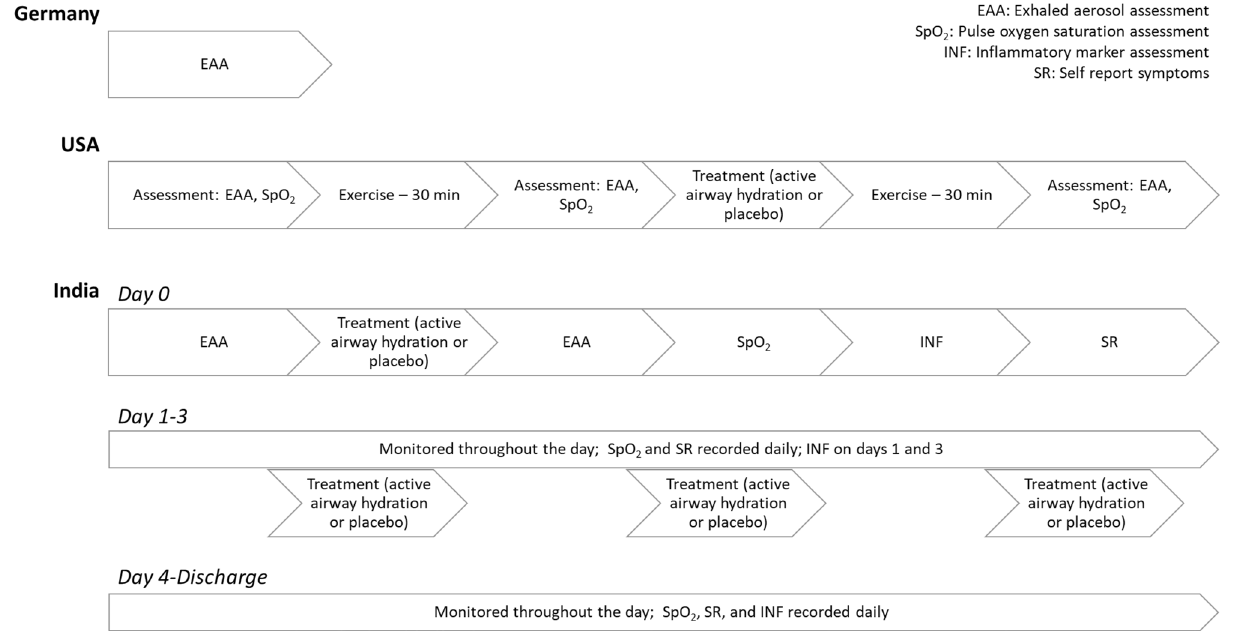
Figure 5. Flowchart of multisite human volunteer